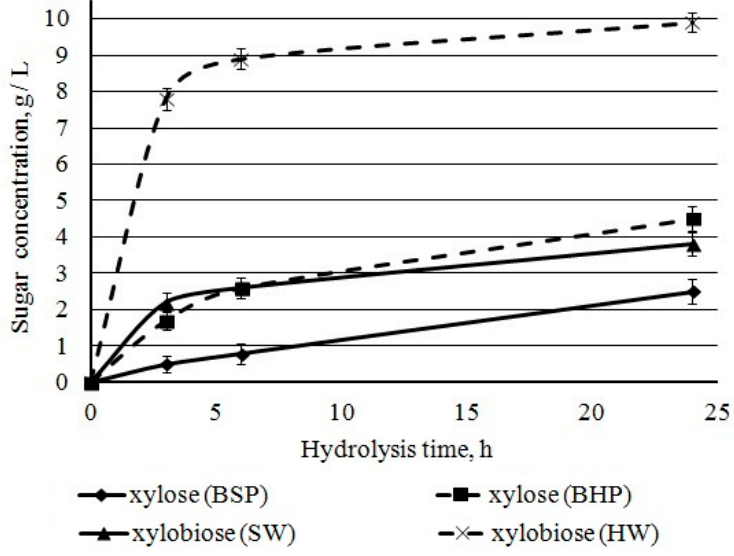
Figure 11. Concentration of xylose and xylobiose in pulp hydrolysates during 24 h of hydrolysis.